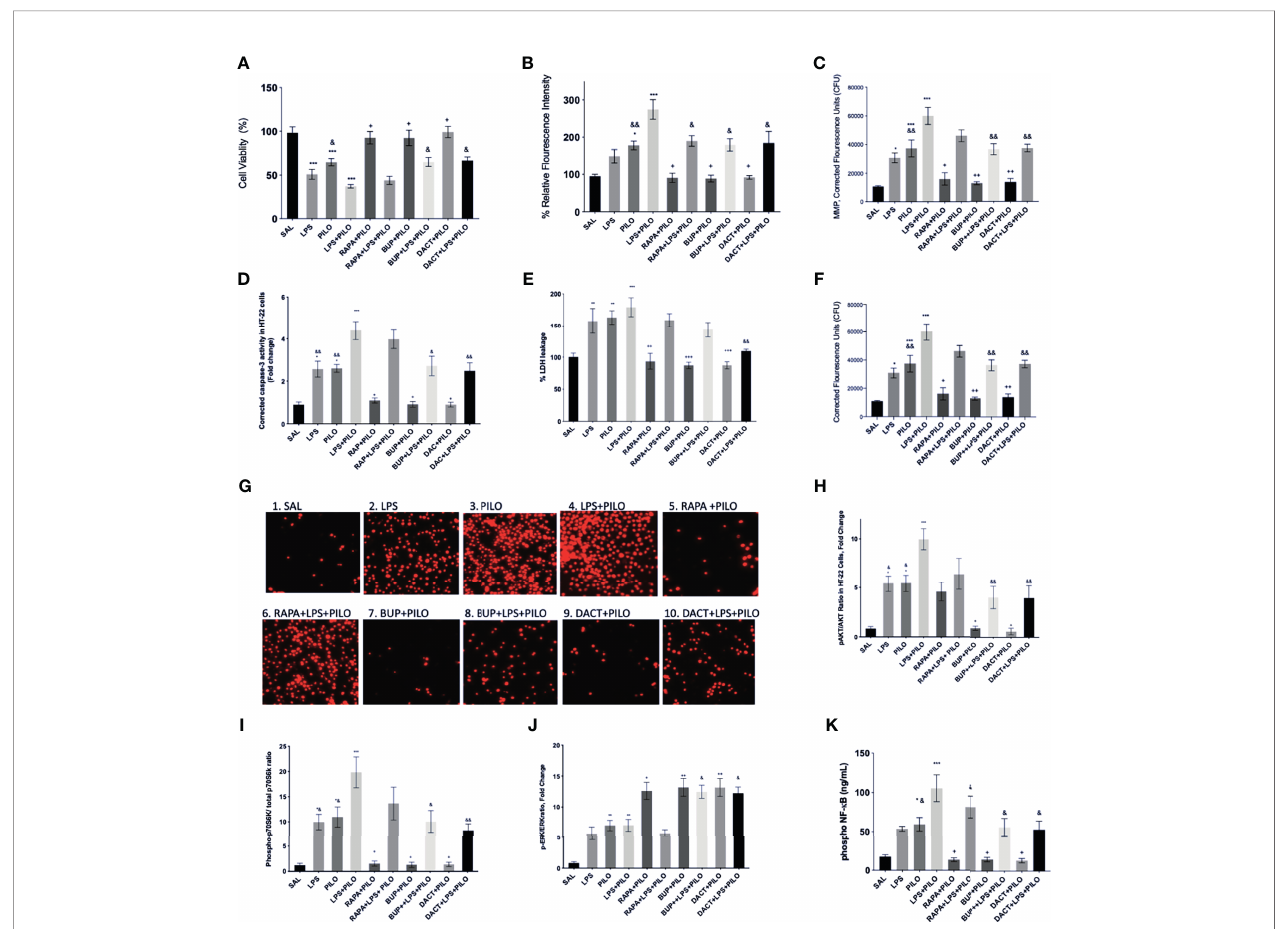
FIGURE 2 | Effects of RAPA, BUP, and DACT on PILO versus LPS+PILO-induced HT-22 cells on: (A) cell viability, (B) ROS levels, (C) mitochondrial membrane potential, (D) cleaved caspase-3, (E) % LDH leakage, (F) nuclear integrity, (G) fl uorescence microscope images of propidium iodide stained HT-22 cells 60X, (H) phospho Akt/total Akt ratio in cell lysates, (I) phospho-p70S6/Total-p70S6 kinase, (J) phospho ERK/total ERK, and (K) phospho NF- k B levels (ng/ml). SAL represents the saline-treated wells (n=6). The data are represented as mean ± SEM and analyzed by one-way ANOVA followed by Tukey Kramer multiple comparison tests. The signi fi cance is ascertained as ***p<0.001 versus SAL, **p<0.01 versus SAL, *p<0.05 versus SAL, ++ p<0.01 versus PILO, + p<0.05 versus PILO, && p<0.01 versus LPS+PILO, and & p<0.05 versus